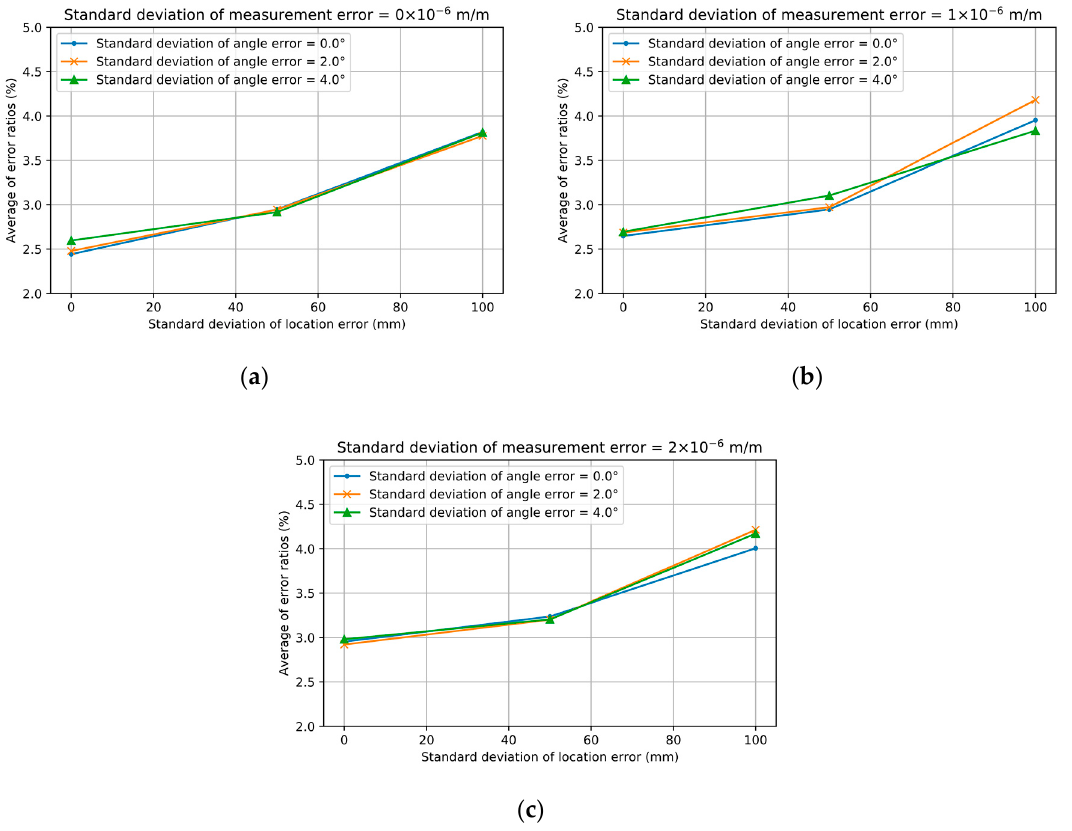
Figure 8. Error ratio in model updating as a result of considering uncertainties in sensor position and direction and measurement noise: ( a ) without measurement error; ( b ) with standard deviation of 1 × 10 (cid:2879)(cid:2874) m/m in measurement error; ( c ) with standard deviation of 2 × 10 (cid:2879)(cid:2874) m/m in measurement 1 × 10 − 6 m/m in measurement error; ( c ) with standard deviation of 2 × 10 − 6 m/m in measurement error.